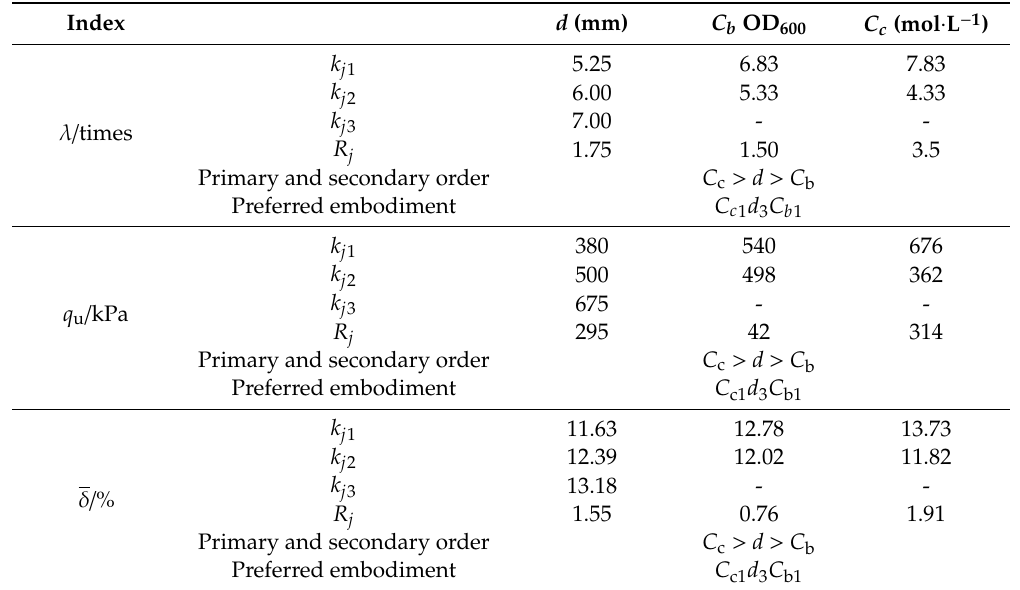
Table 4. The values of K jm , k jm , and R j at each factor